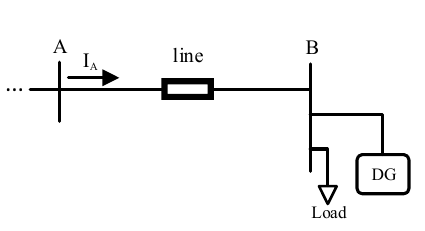
Figure 11. Network with lumped downstream.